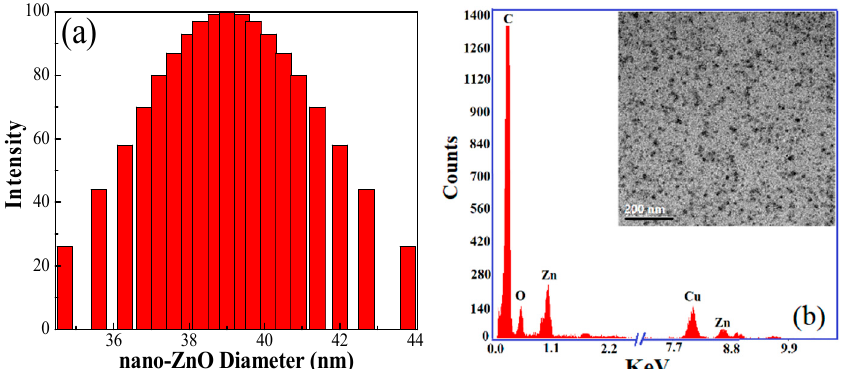
Figure 1. ( a ) The diameter of ZnO NPs; ( b ) the energy dispersion spectrum (EDS) analysis of TEM on the ZnO NPs.